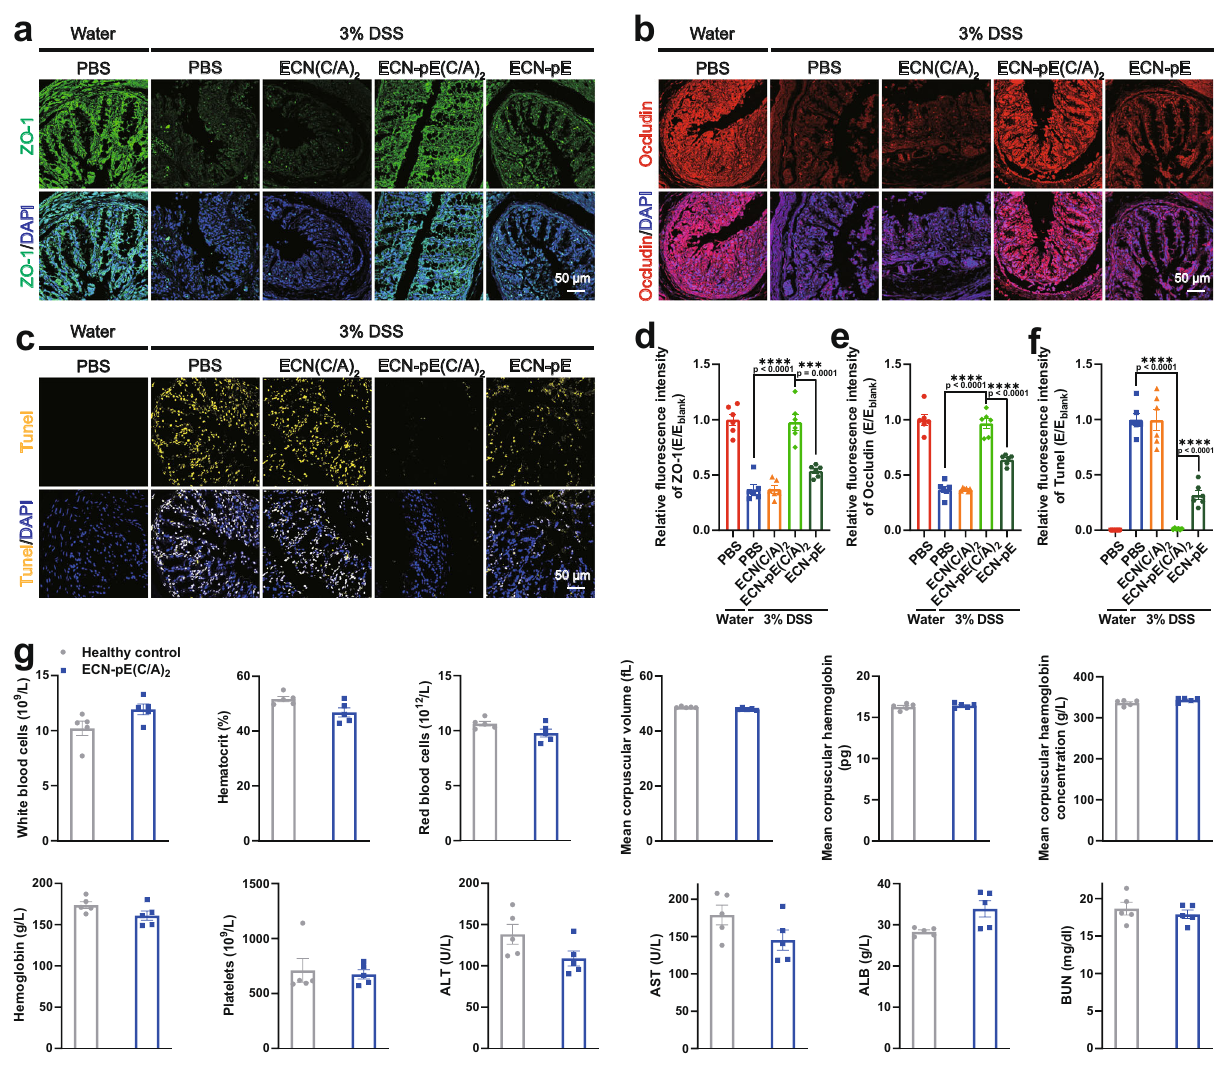
Fig. 4 Reparative effect of ECN-pE(C/A)2 on the colonic epithelium and in vivo safety evaluation. a , b Representative immuno fl uorescence staining images of colon sections to indicate the expression of tight junction proteins, including ZO-1 ( a ) and Occludin ( b ), 10 days after different treatments from two biologically independent animals. d , e Relative fl uorescence intensity of colon sections as shown in ( a ) and ( b ). The nuclei were stained with DAPI (blue). Scale bar: 50 μ m. c Representative TUNEL staining images of the colon tissues of mice in different groups from two biologically independent animals. f Relative fl uorescence intensity of colon sections as shown in ( c ). The nuclei were stained with DAPI (blue). Scale bar: 50 μ m. The mice were given PBS or ECN-pE(C/A) 2 (1 × 10 8 CFU) on days 0, 2, 4, and 6 by gavage. g Complete blood and serum biochemistry data were obtained on day 10 after ECN-pE(C/A) 2 treatment. ALT alanine aminotransferase, AST aspartate aminotransferase, ALB albumin, BUN blood urea nitrogen. Data are presented as mean values ± SEM ( n = 6 biologically independent samples for ( d – f ), n = 5 biologically independent samples for ( g )). Statistical analysis was evaluated with two-tailed Student ’ s t tests (* P < 0.05, ** P < 0.01, *** P < 0.001, and **** P < 0.0001). ZO-1 zonula occludens-1, DAPI 4 ’ ,6-diamidino-2-phenylindole, DSS dextran sodium sulfate. Source data are provided as a Source Data fi